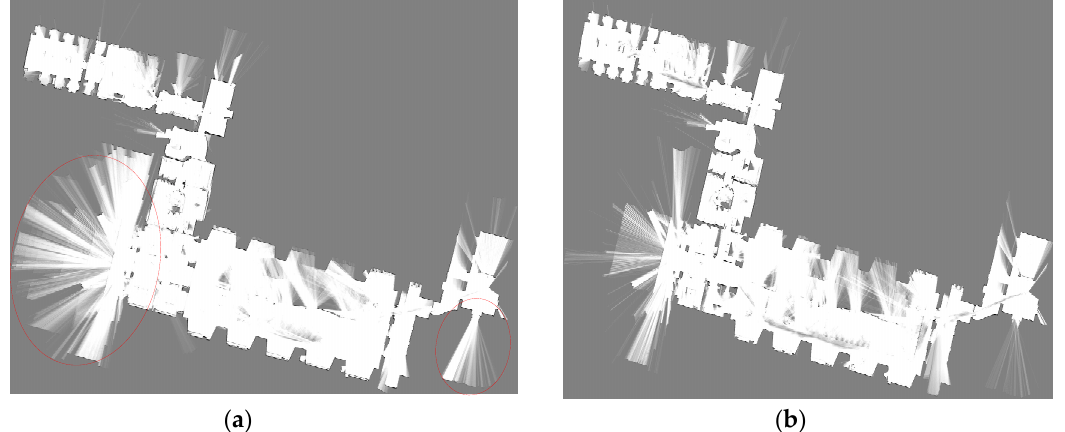
Figure 13. Map built by Cartographer (LiDAR only) ( a ) and the proposed method ( b ) with file b0-2014-10-07-12-43-25.bag [48].